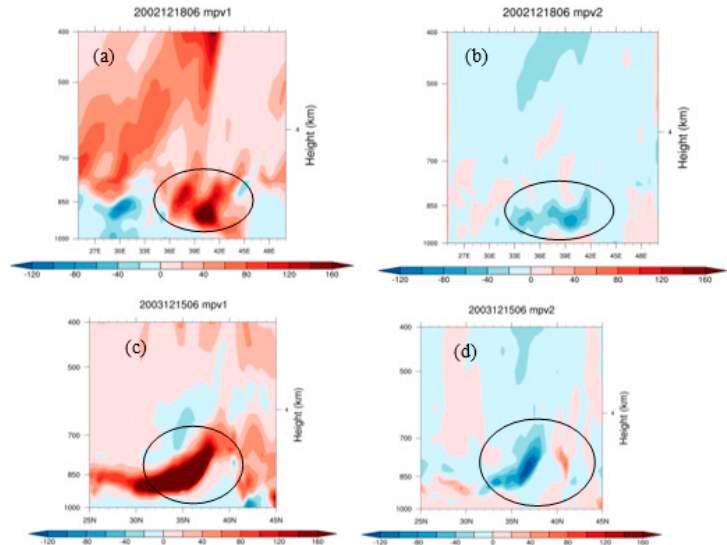
Figure 8. Meridional and zonal vertical cross-sections of inertial and baroclinic instability. ( a ) MPV1 > 0 along longitude; ( b ) MPV2 < 0 along longitude; ( c ) MPV1 > 0 along latitude; and ( d ) MPV2 < 0 along latitude. Longitude: mean of 38° E–42° E, latitude: mean of 34° N–36° N.